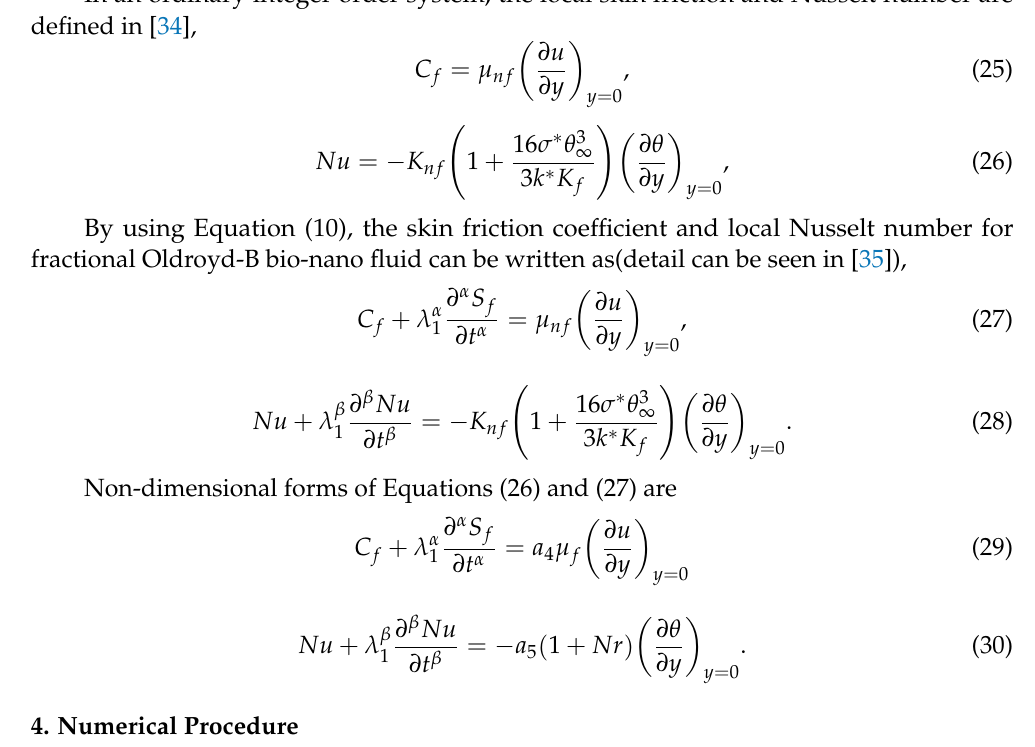
Base Fluid (Blood)